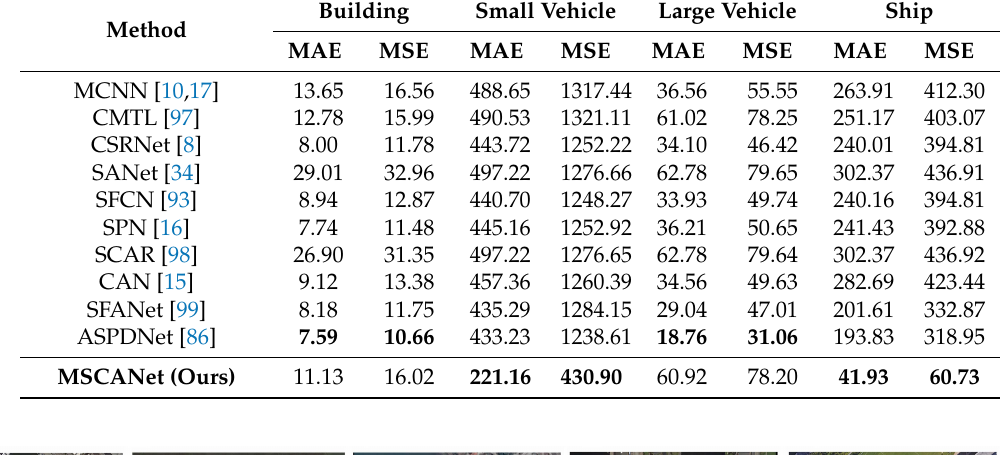
Table 3. Comparison of the different state-of-the-art methods on RSOC .